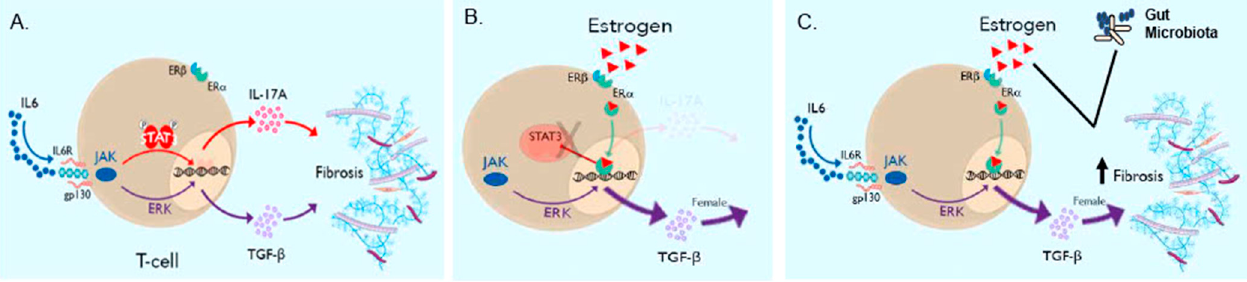
Figure 7. Graphical abstract of the interaction of gonadal hormones and gut dysbiosis in lung fibrosis . ( A ) IL-6 induces profibrotic cytokine expression through IL-17A and TGF- β 1 expression. IL-17A drives inflammation in fibrotic lung tissue. ( B ) The alpha subunit of the estrogen receptor (ER α ) serves as a transcription factor and physically binds to the STAT3 promoter, thus inhibiting the Th17 cell-mediated inflammation associated with fibrosis. ( C ) The presence of estrogen and gut dysbiosis augments lung fibrosis through TGF- β 1 expression, thus demonstrating that multiple factors contribute to lung fibrosis pathophysiology.